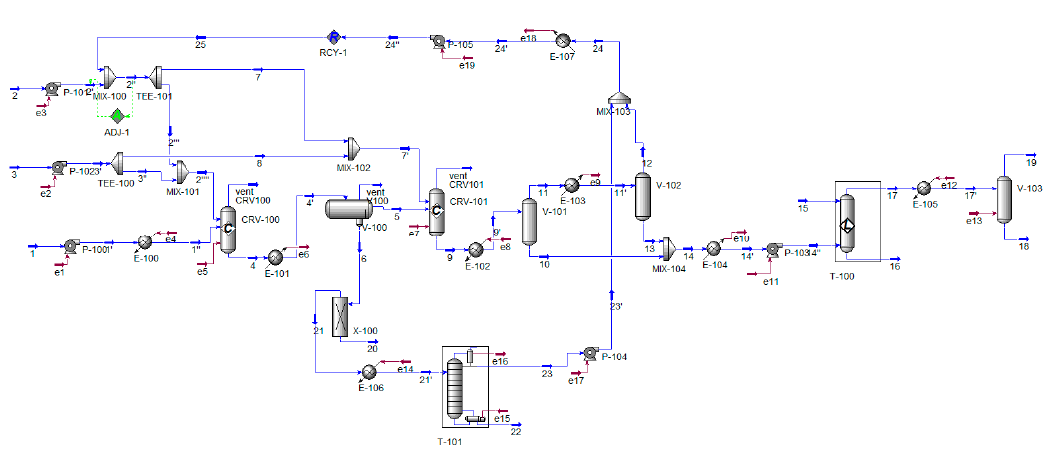
Figure 3. Process flowsheet. Table 5. Properties of the main streams (part I).